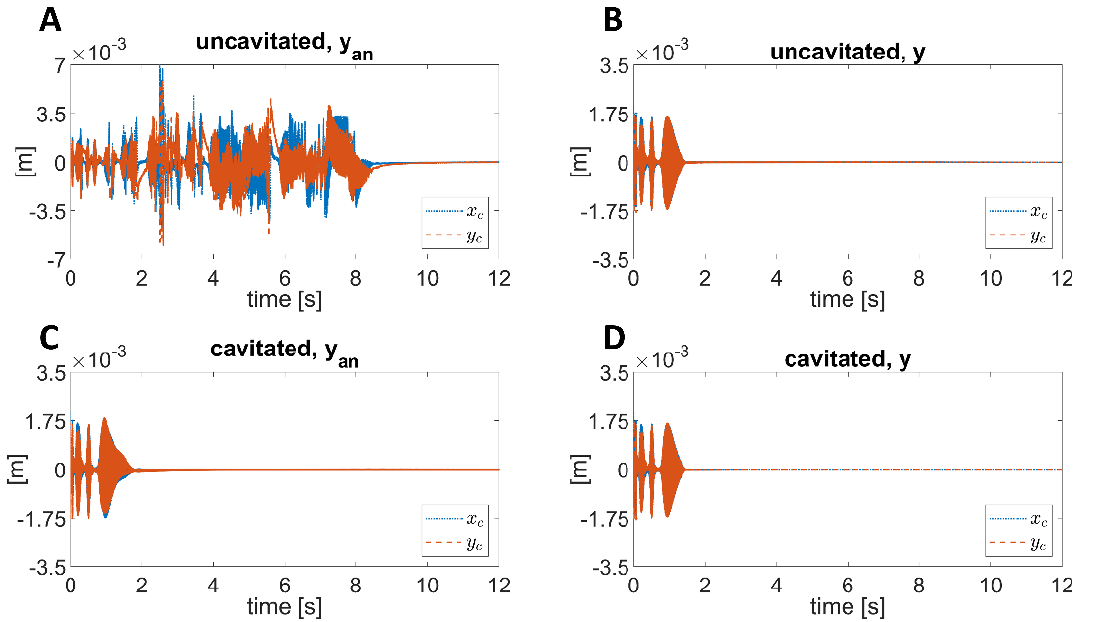
Figure 13. Control vector ˆ u x = [ ˆ u x ,1 , ˆ u x ,2 ] T for uncavitated and cavitated conditions with analytical for uncavitated and cavitated conditions with analytical Figure 13. Control vector output noise ( A , C ) and for uncavitated and cavitated conditions with measured output noise ( B , D ). 𝑇𝑇 output noise ( A , C ) and for uncavitated and cavitated conditions with measured output noise ( B , D ). 𝑚𝑚� 𝑥𝑥 = �𝑚𝑚� 𝑥𝑥 , 1 , 𝑚𝑚� 𝑥𝑥 , 2 � Figure 14 illustrates the disturbance attenuation on disc center coordinates [ x c , y c ] in for uncavitated and cavitated conditions with analytical Figure 13. Control vector the four simulation cases. 𝑇𝑇 output noise ( A , C ) and for uncavitated and cavitated conditions with measured output noise ( B , D ). 𝑚𝑚� 𝑥𝑥 = �𝑚𝑚� 𝑥𝑥 , 1 , 𝑚𝑚� 𝑥𝑥 , 2 �